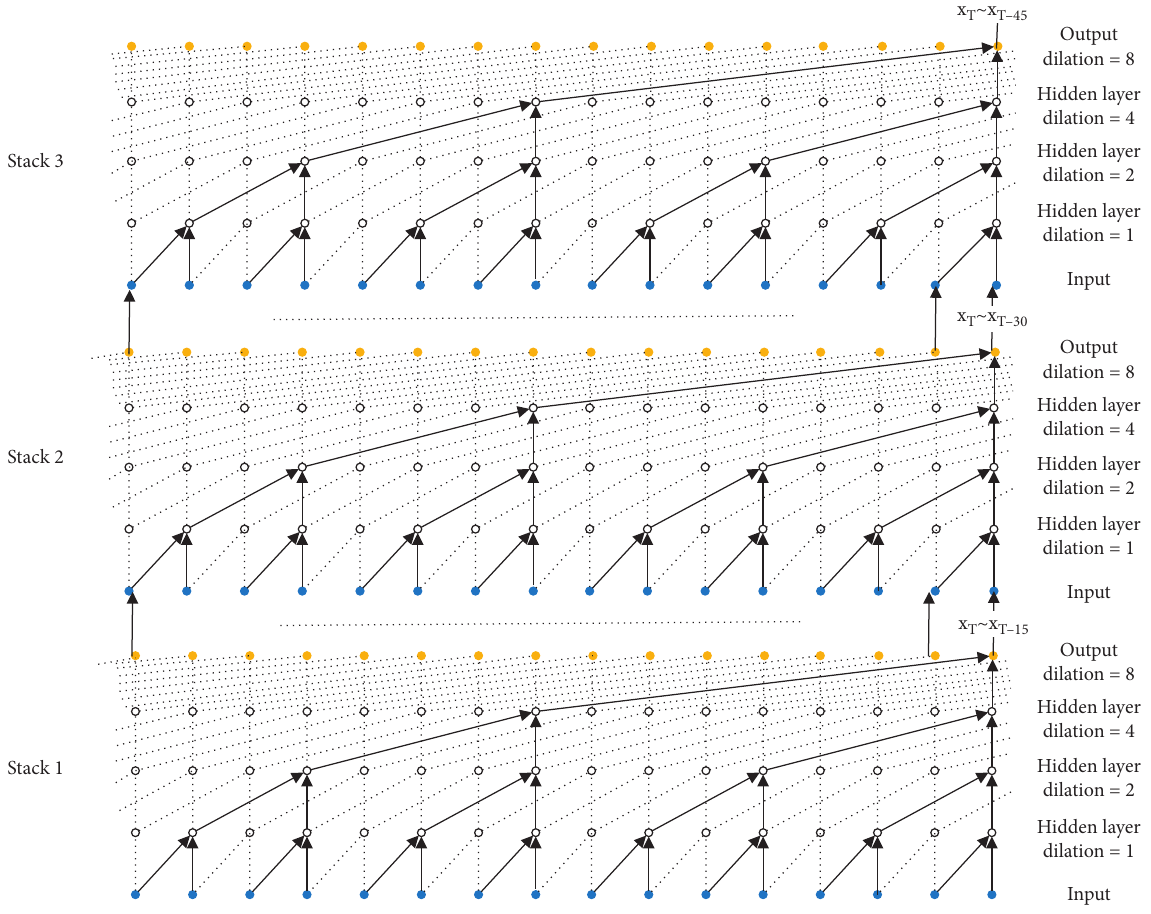
Figure 2: 3 stacks of 5 dilated causal convolutional layers with filter length 2.